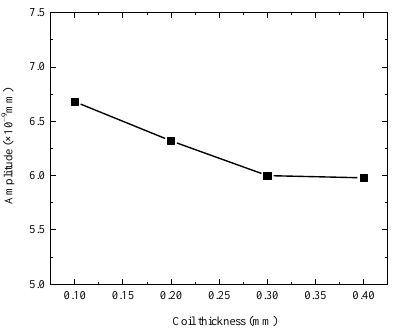
Figure 20. The influence of coil width on the amplitude of received signal.